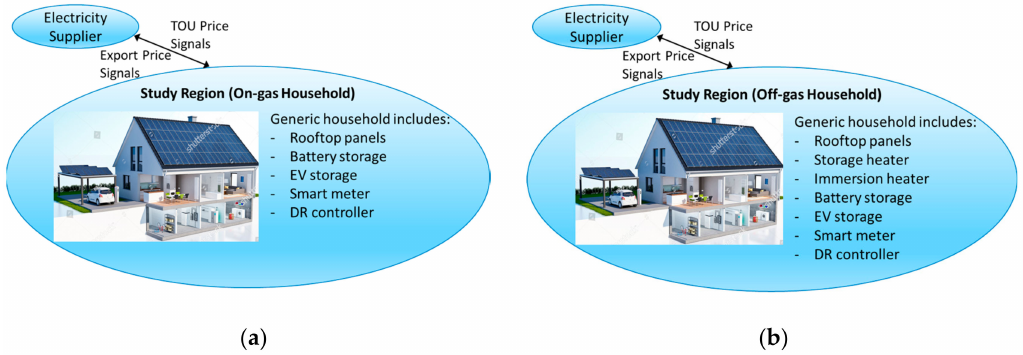
Figure 1. ( a ) On-gas and ( b ) o ff -gas households adopting demand response scheme and EV. TOU: time of use, EV: electric Vehicle, DR: demand